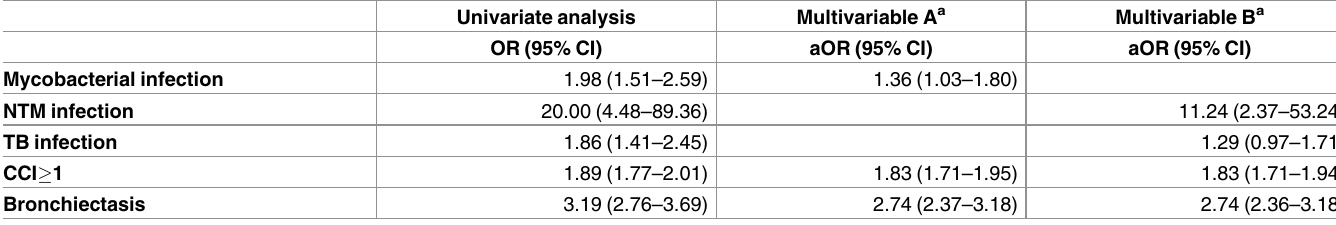
Table 2. Unadjusted and adjusted odds ratios for the association between variables and the risk of Sjogren’s syndrome.